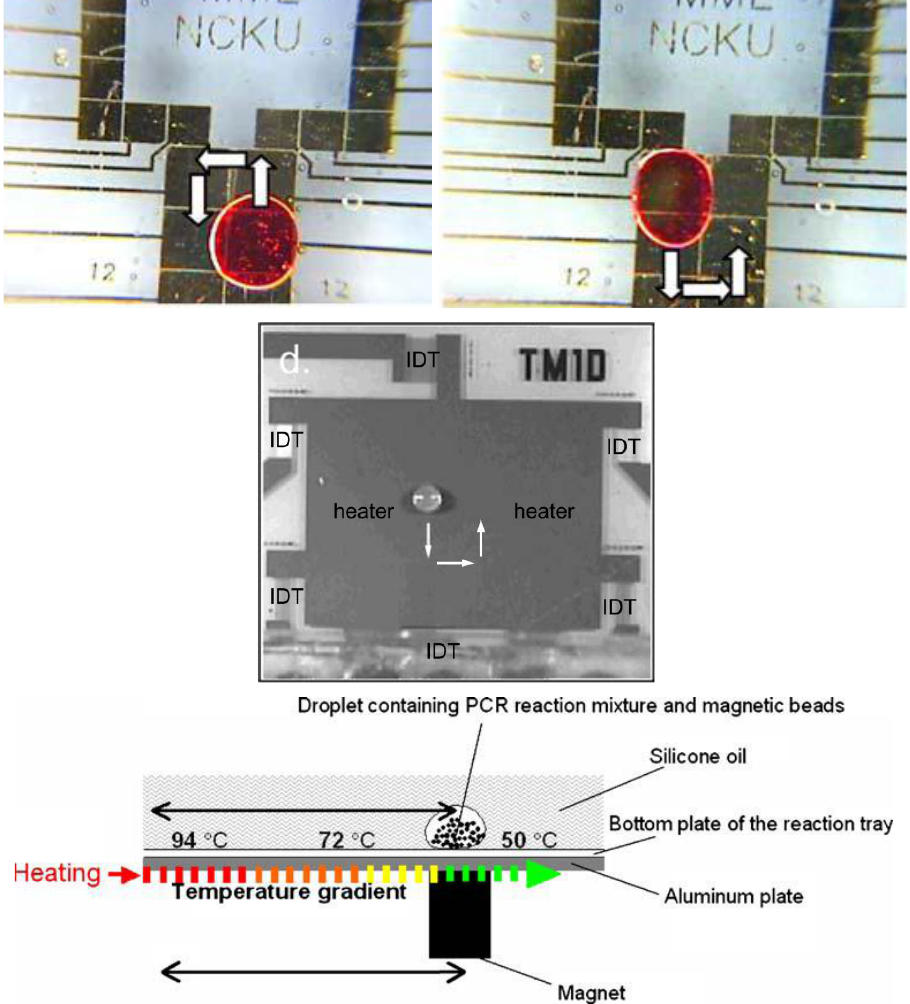
Figure 12. PCR demonstrations in digital microfluidics: EWOD (top), SAW (middle), and magnetofluidics (bottom). Reprinted from [89] and [91] with permission © Springer. Reprinted [90] with permission © Royal Society of